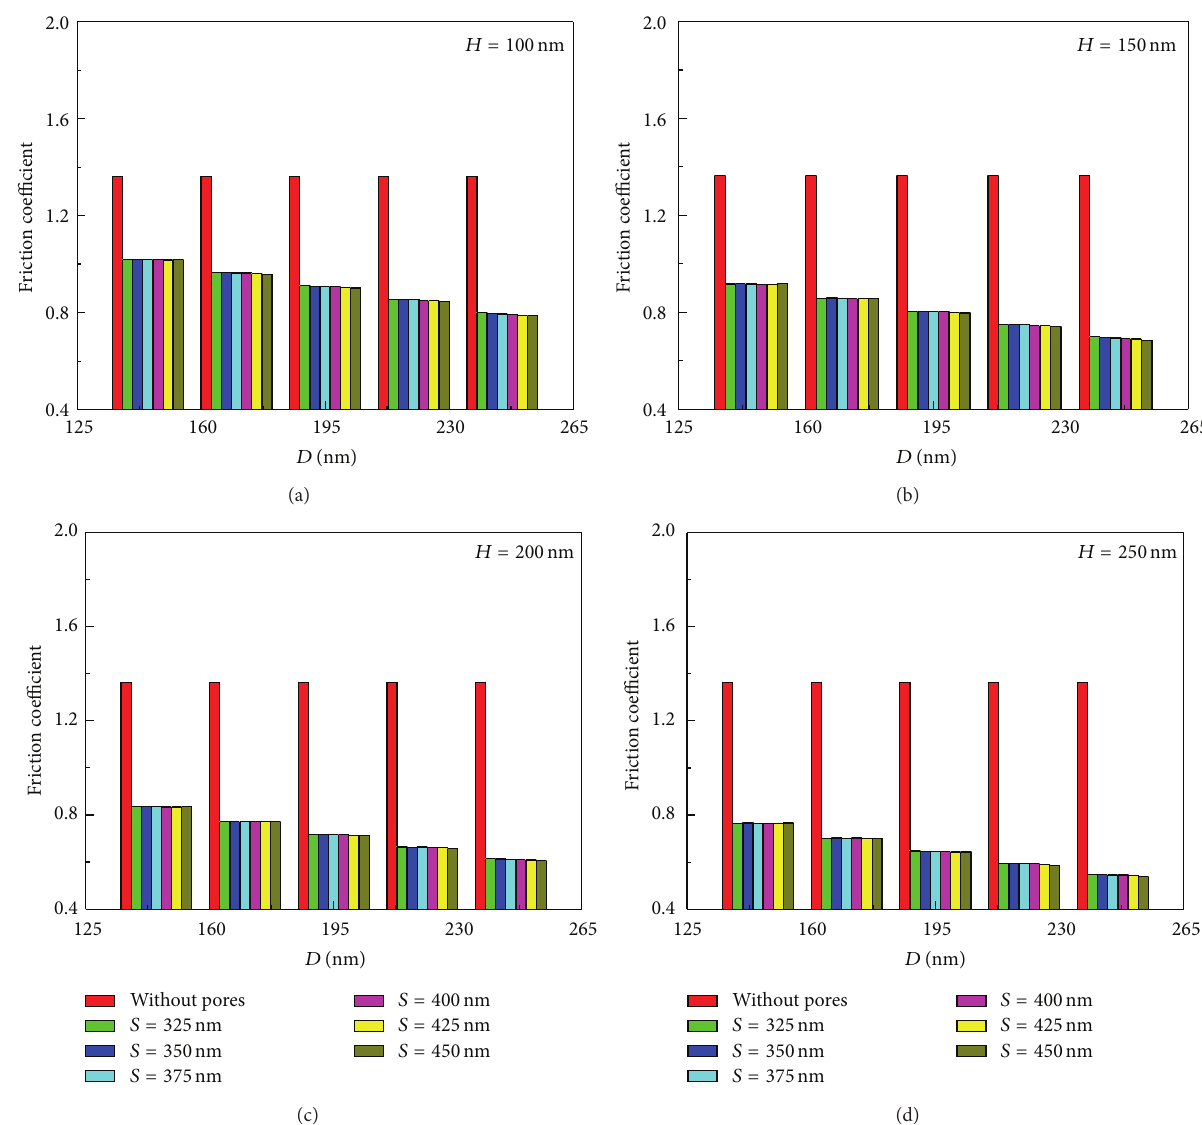
Figure 10: Friction coefficient at different intervals of pore: (a) at depth of 100 nm, (b) at depth of 150nm, (c) at depth of 200 nm, and (d) at depth of 250